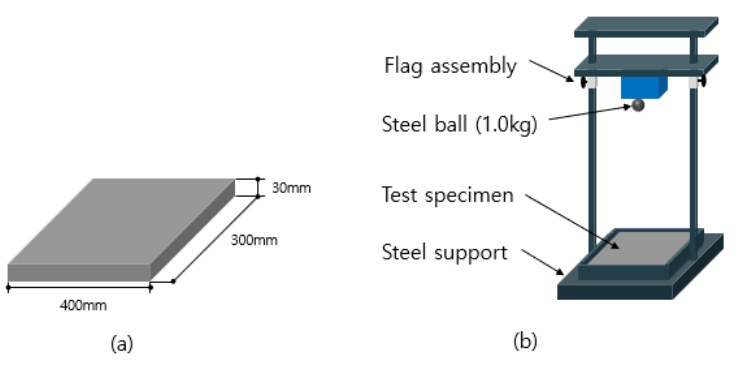
Figure 5. Impact resistance test; ( a ) schematic diagram for specimen fabrication, and ( b ) used apparatus for implementation of impact resistance test.